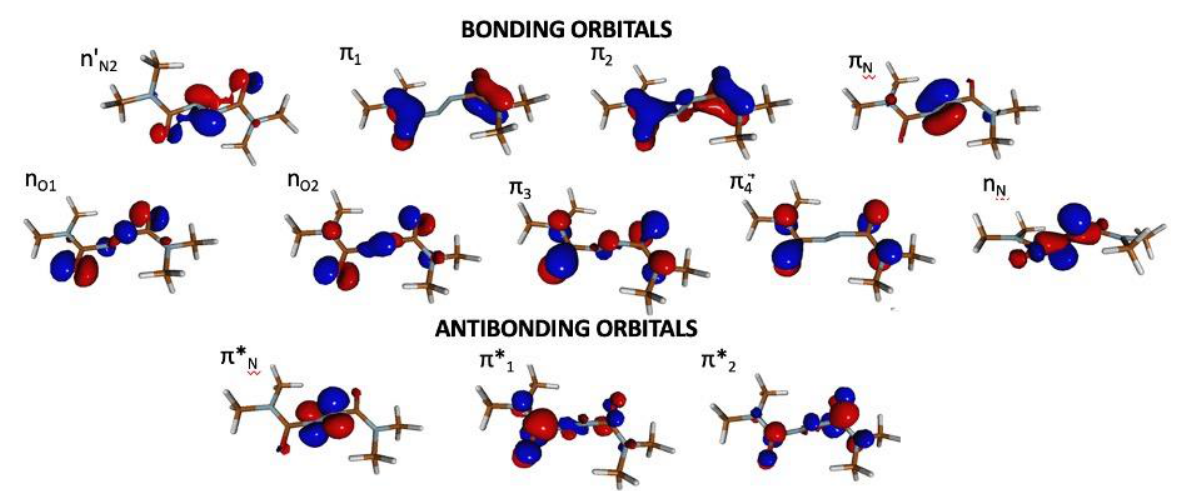
Figure 2. Active space (18,12) employed for CASPT2 calculations. Table 1. Structural parameters obtained at several critical points along the S 0 and S 1 potential energy surfaces of the gas-phase and solvated chromophore. The S 0 minimum was obtained at the MP2/6- 31G* level, whereas the remaining points at the SS-CASPT2/SA-2-CASSCF(18,12) level.